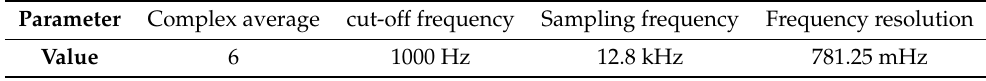
Table 3. List of parameters for data